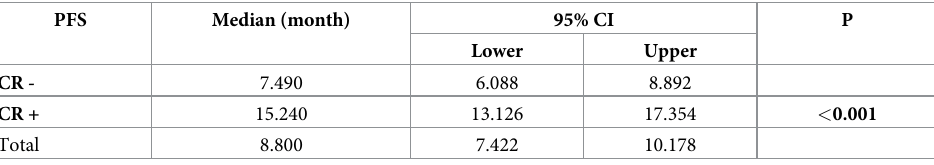
Table 3. Progression-free survival analysis based on whether a complete response was attained. PFS Median (month) 95%